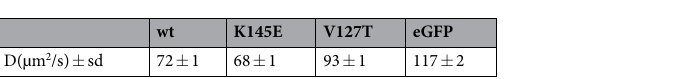
Table 2. Comparison of the diffusion coefficients of SAASoti measured by